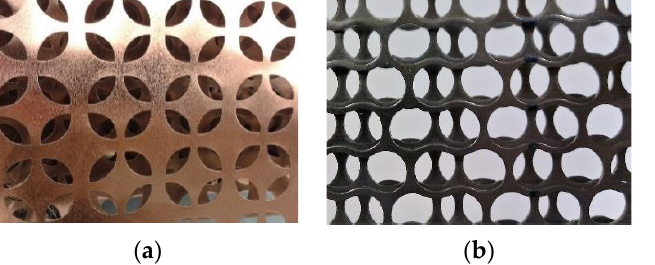
Figure 6. Fragments of panels: from two perforated steel strips laid with a copper shift ( a ), from steel several strips laid in parallel ( b ).